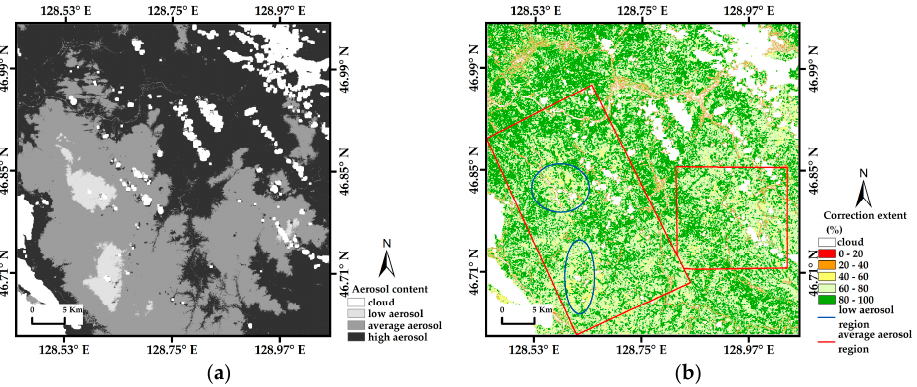
Figure 7. Aerosol distribution and correction extent (%) after aerosol correction by the proposed algorithm in the second sub research area. ( a ) Aerosol distribution; and ( b ) correction extent. Table 5. Correction extent (%) under different aerosol loading conditions.